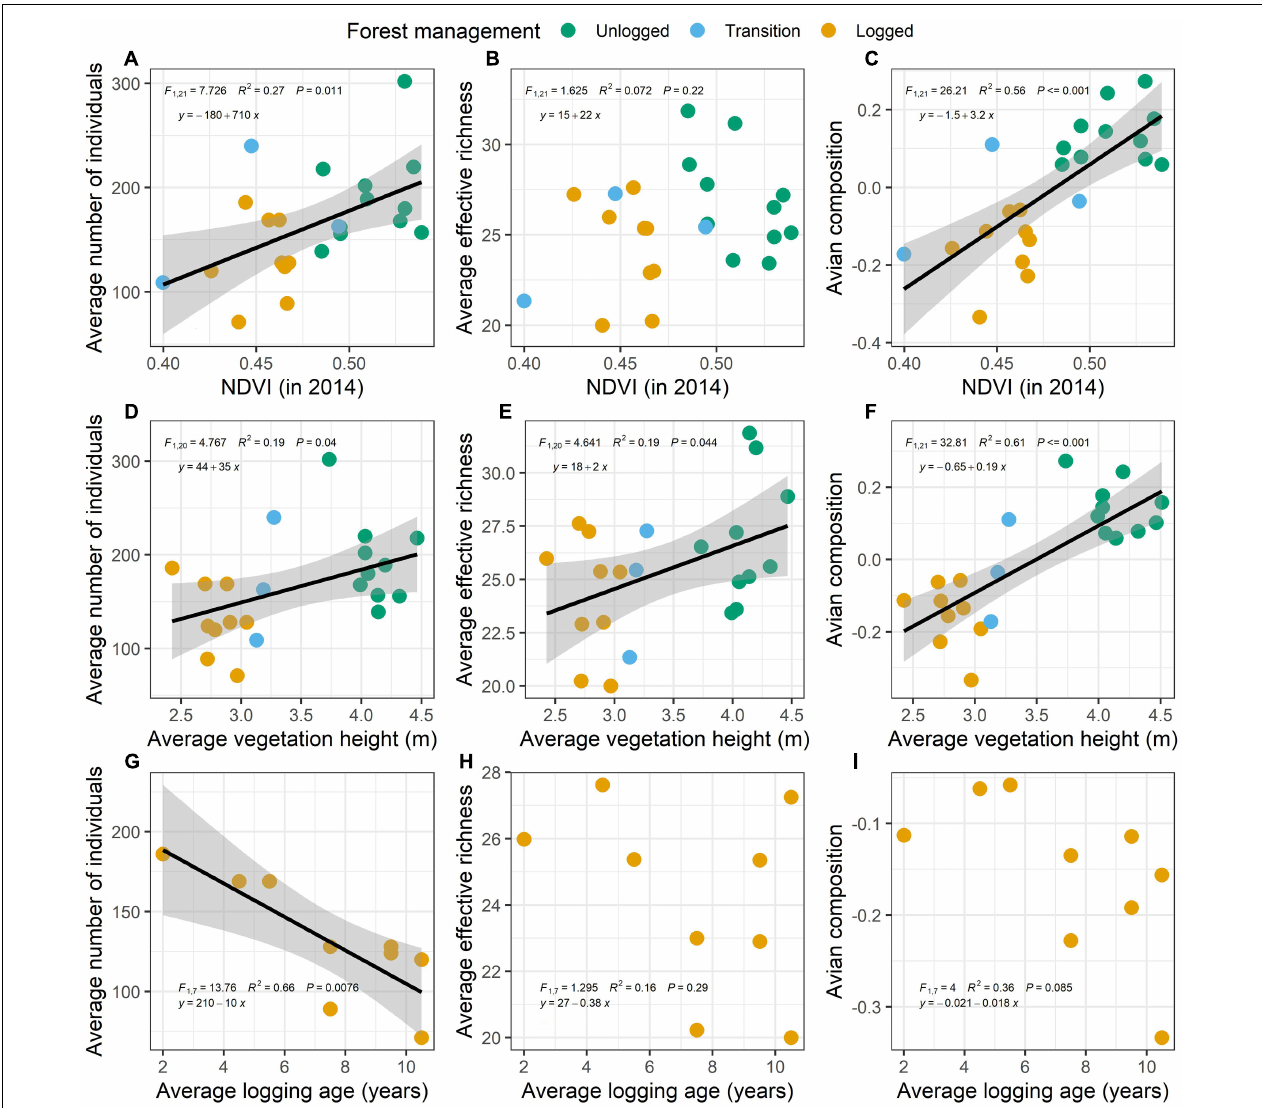
FIGURE 5 | Linear regressions models between avian abundance (A,D,G) , species richness (B,E,H) , and avian composition (C,F,I) obtained from 160 point counts and averaged by 23 (or 9 as logging age) half-trails sampled and the normalized difference vegetation index (NDVI in 2014) (A–C) , vegetation height (D–F) , and the logging age (in years prior to 2014, the time of our sampling) (G–I) , averaged from the two forest stands aside of each 23 (or 9 as logging age) half-trails of the management area at Fazenda Pau D’Arco, Crato, Ceará, Brazil. Dots indicate unlogged (dark green), transition (blue), and logged (yellow) half-trails. The regression line was derived from the data points and smooth areas are the standard deviation for significant regression